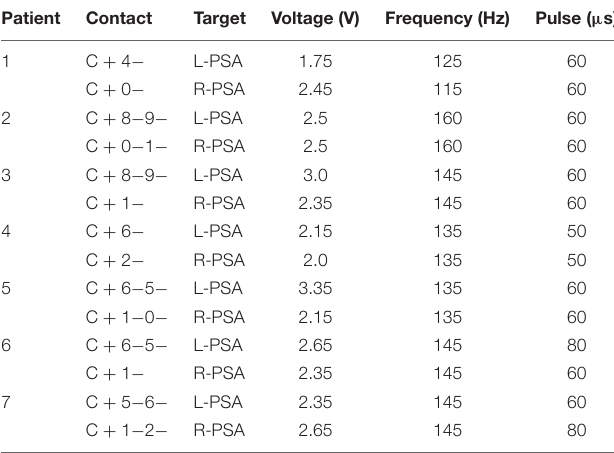
TABLE 4 | Electrode position and final stimulation parameters.